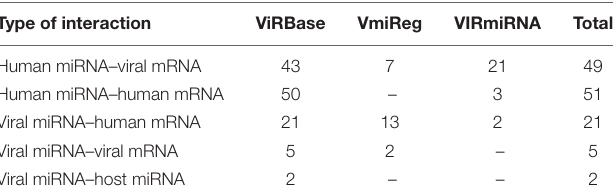
TABLE 3 | Various types of interactions between HIV-1 and human RNAs presented in public